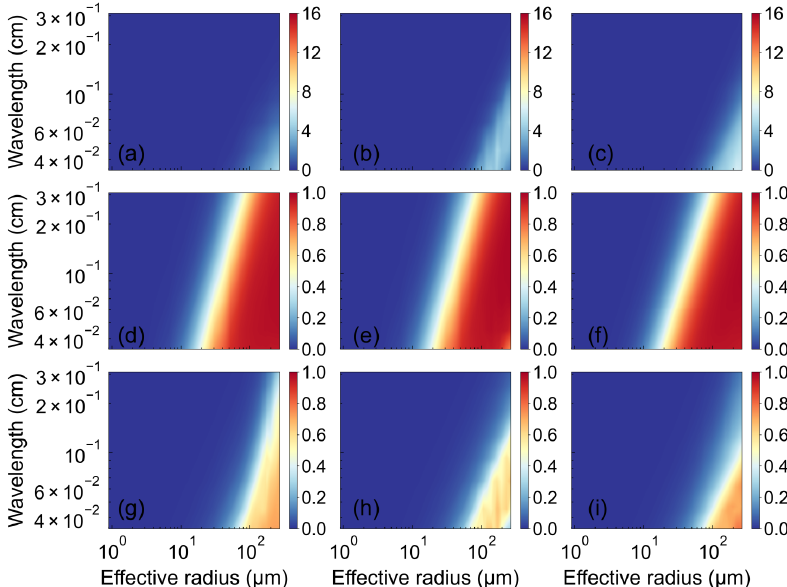
Figure 3. The comparison of the extinction efficiency, single-scattering albedo, and asymmetry factor as functions of 31 particle sizes (1–270µm) and 20 terahertz wavelengths (0.03–0.3cm) for the (a, d, g) Voronoi, (b, e, h) sphere, and (c, f, i) column ICS